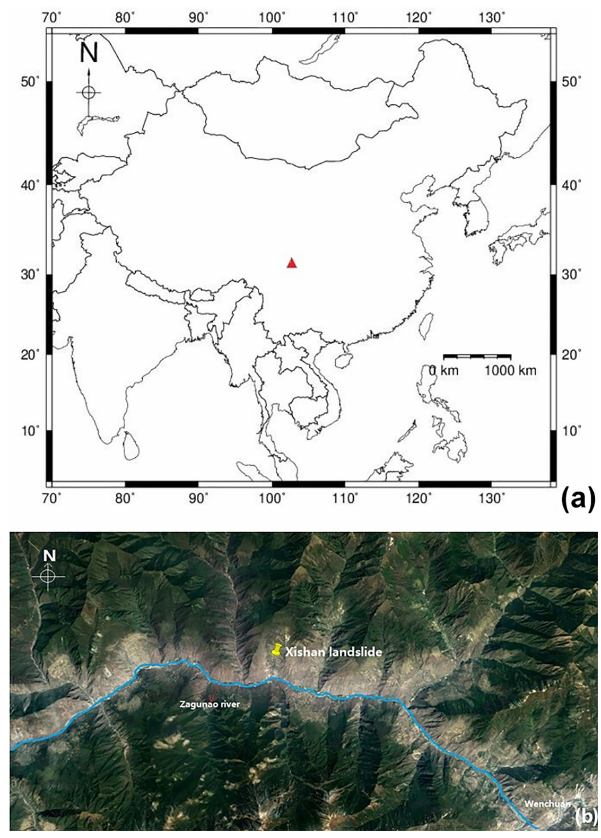
Figure 2. Location of the Xishan landslide in China (a) ; the Xishan landslides in the west of Wenchuan County associated with land- form. Map obtained from Google Earth (b)